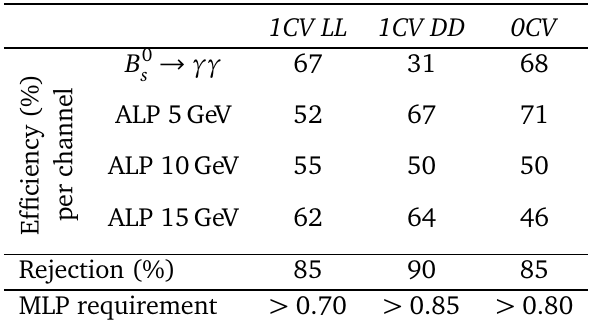
and ALP samples relative to the recon- s